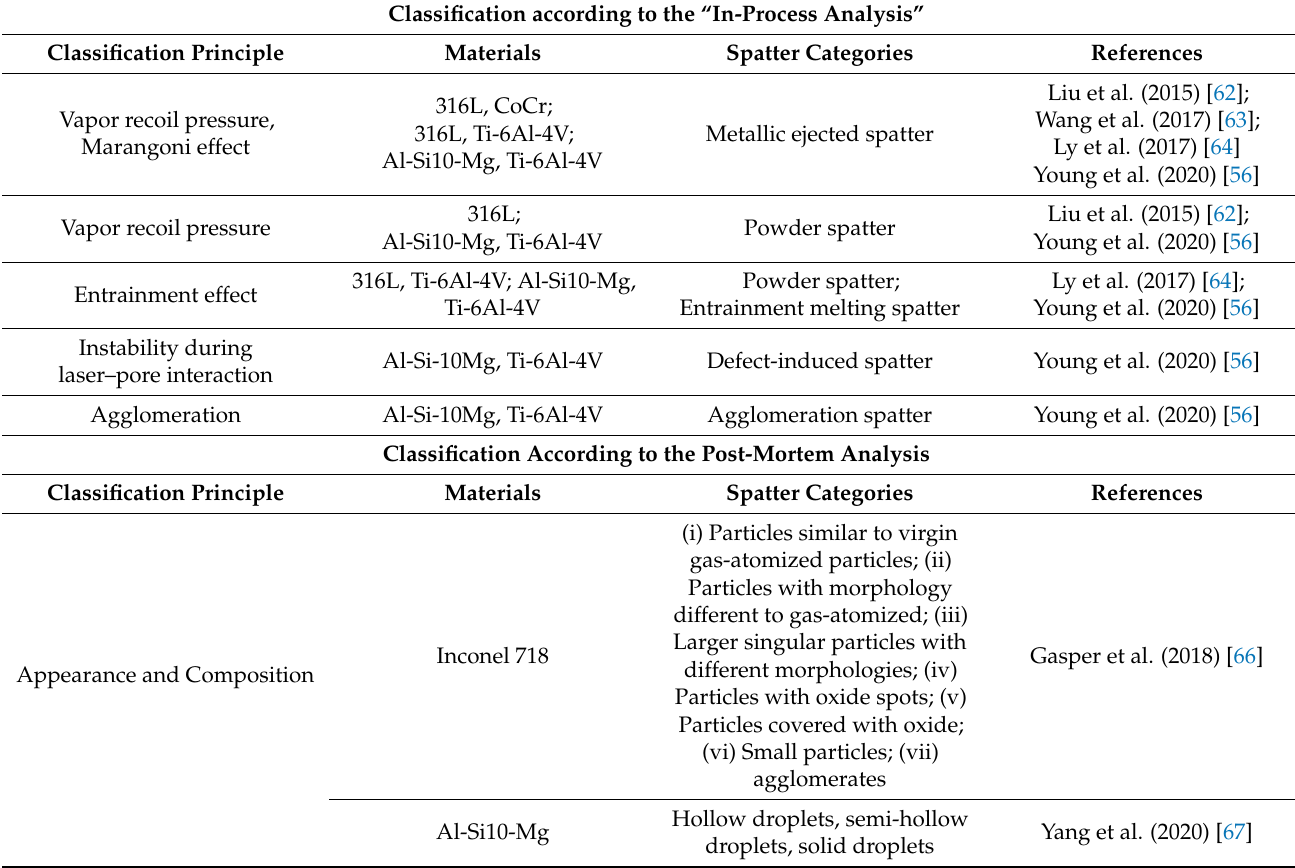
Table 3. Summary of spatter classification